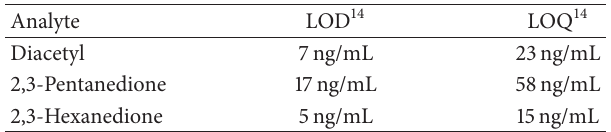
Table 5: Recovery results for the on-tube derivatization of diacetyl, 2,3-pentanedione, and